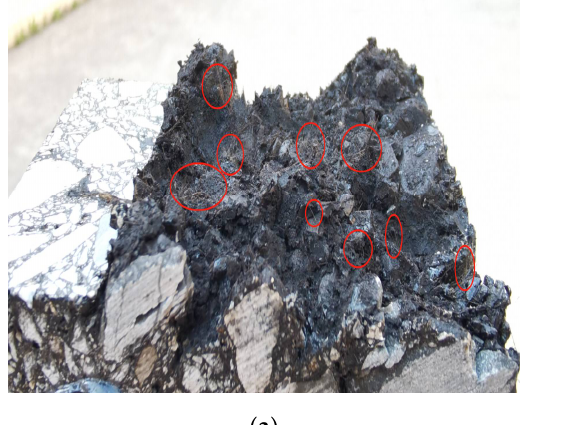
Figure 8. Typical fracture modes based on RA and AF.